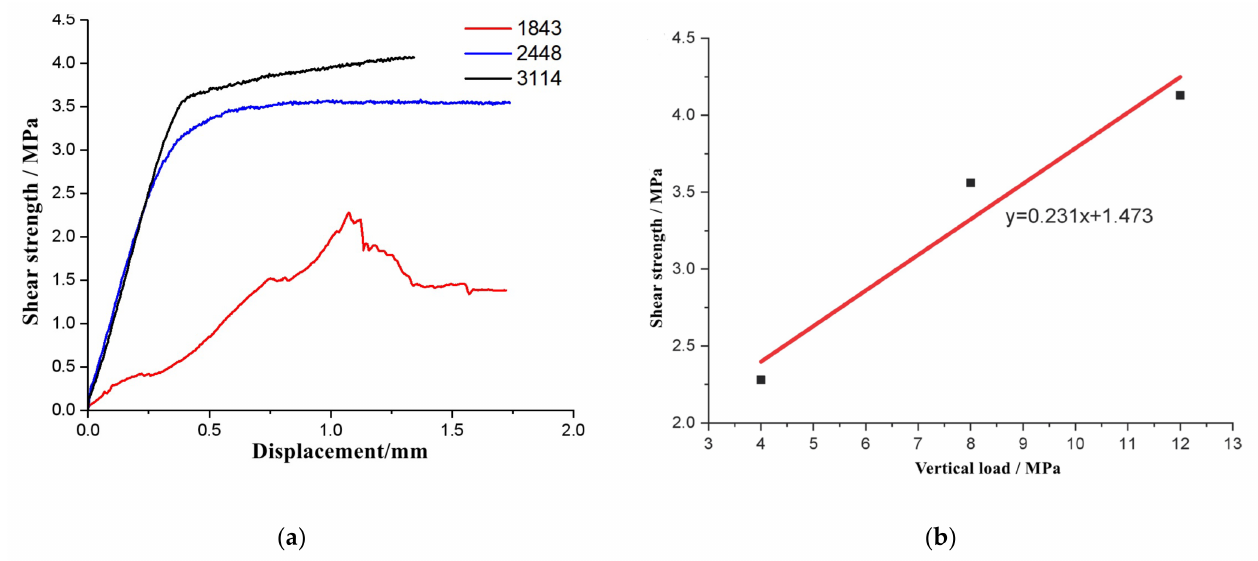
Figure 6. Shear parameters of the samples: ( a ) Shear resistance curves; ( b ) Strength fitting